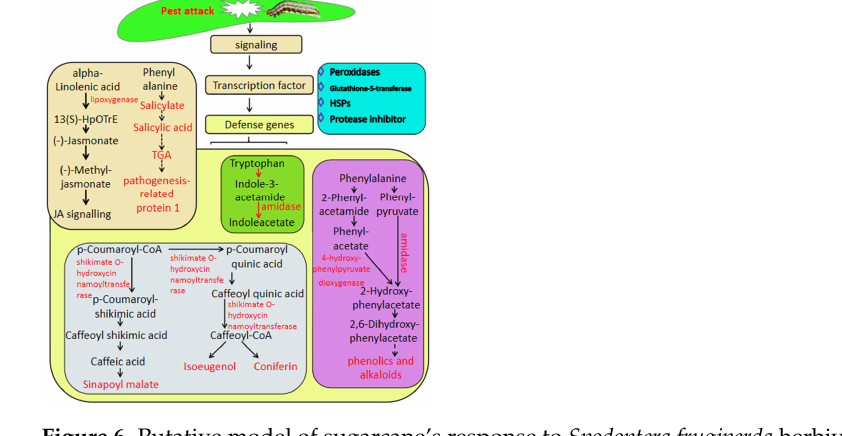
Figure 6. Putative model of sugarcane’s response to Spodoptera frugiperda herbivory. The names in light-type letters are metabolite compounds. The DEGs are exhibited in bold type with the arrows.